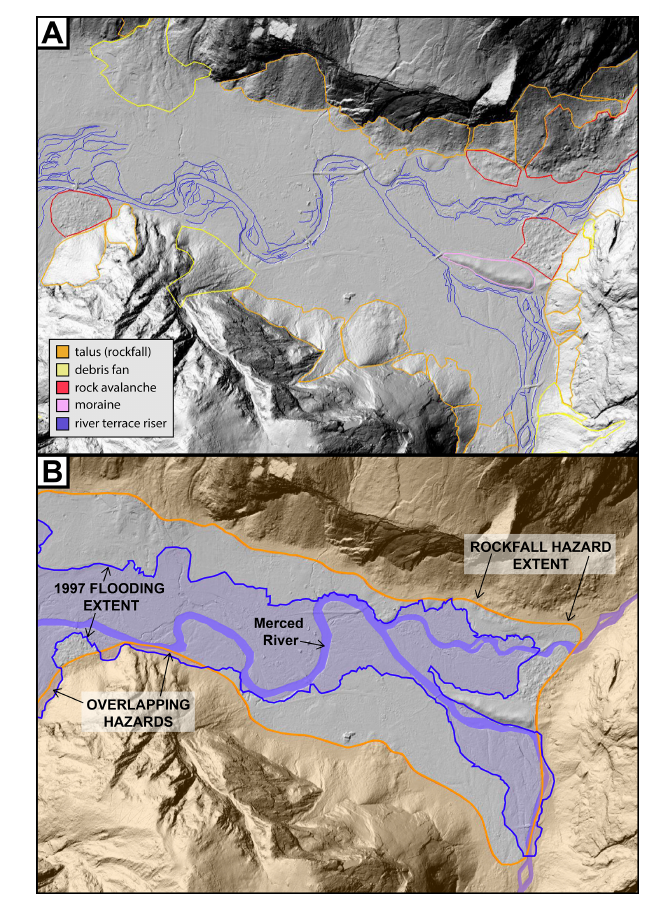
Figure 5. From geomorphic mapping to hazard planning. (a) An excerpt from a virtual summer field student geomorphic map, which scored “highly competent” (still room for improvement), submit- ted as a © Google Earth KMZ file (final product of Part III of the activity). The basemap shown in both panels is a hillshade of bare-Earth airborne lidar data collected by the National Center for Airborne Laser Mapping (NCALM), hosted online by OpenTopog- raphy (https://doi.org/10.5069/G9GQ6VP3; Yosemite, CA, 2021). Students use a combination of the lidar visualizations and satellite imagery provided to map deposits based on texture, slope, and val- ley position. (b) A visualization of two hazard extents utilized by Yosemite National Park and provided to students. The blue line indi- cates the maximum extent of January 1997 flooding (approximating a 100-year flood). The orange line indicates the expected extent of rockfall hazard within the valley (i.e., beneath the valley walls) from Stock et al. (2014). In Part IV of the activity, students use their ge- omorphic mapping and these hazard extents to examine the hazards posed to existing infrastructure and identify areas of lower hazard suitable for further development. Geologically based justifications are expected for all of their recommendations. Location, scale, and orientation are deliberately excluded from this figure. The width of valley floor here is ∼